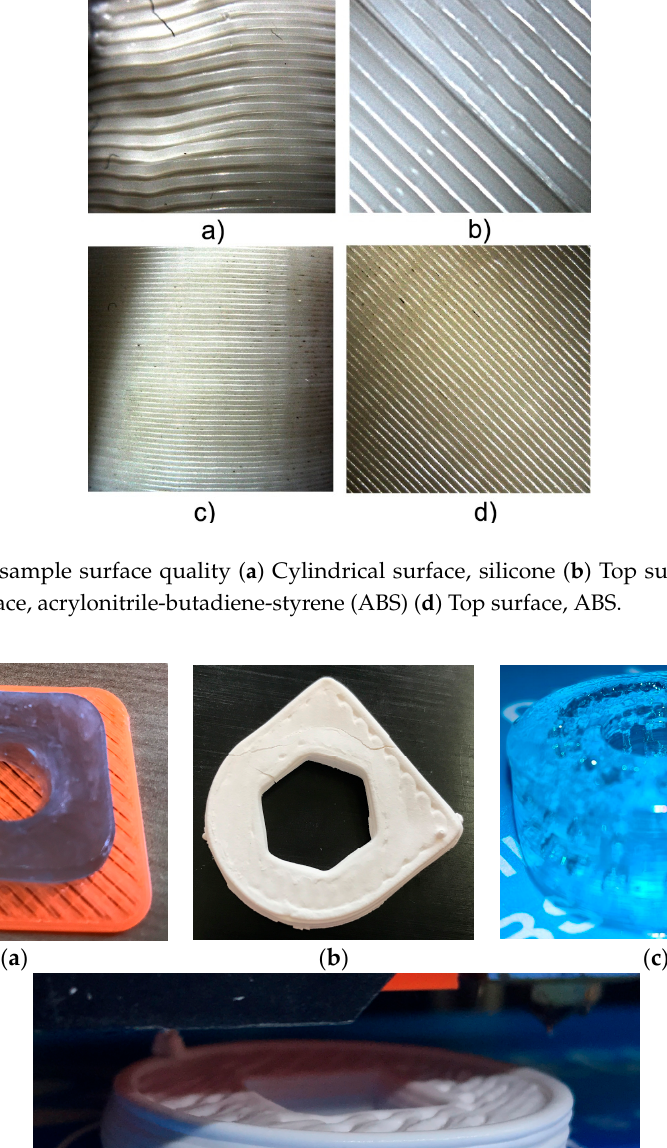
Figure 13. Fabricated parts using the proposed solution ( a ) Part fabricated using silicone ( b ) Part fabricated using white cement mixture ( c ) Part fabricated using commercial dental gel ( d ) Part fabricated using white cement mixture.